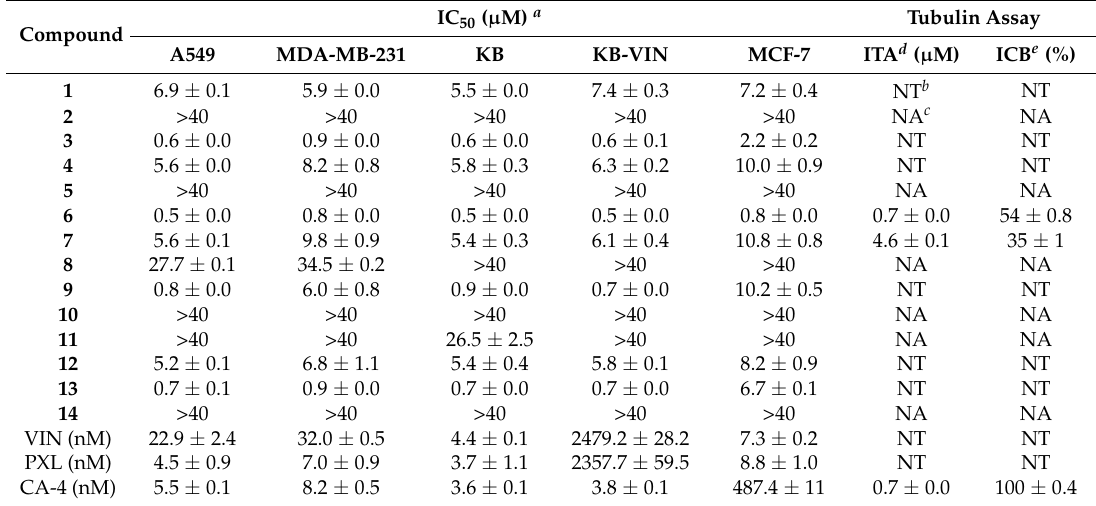
Table 1. Antiproliferative activity and effect on tubulin